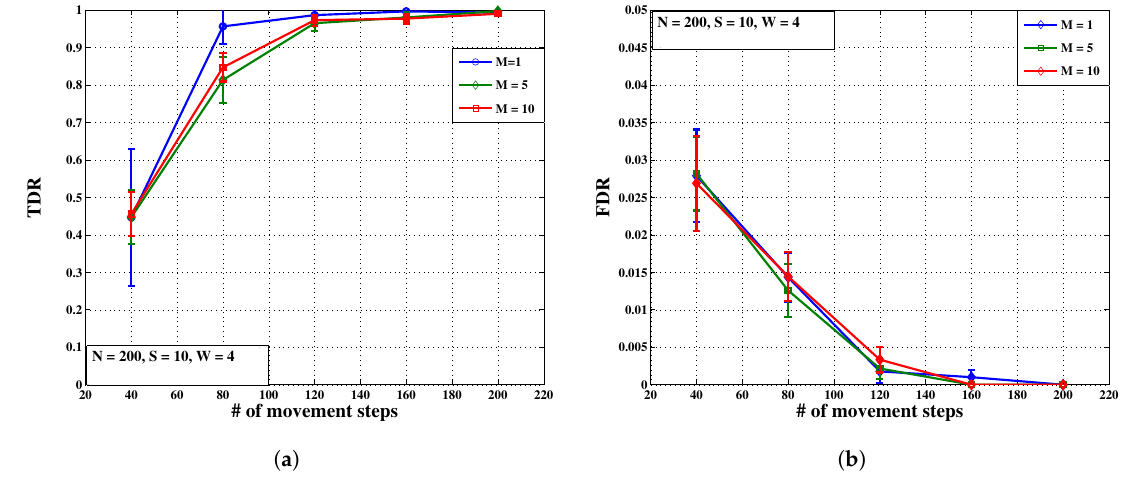
Figure 9. Time variations of TDR ( a ) and FDR ( b ) for different malicious node populations.